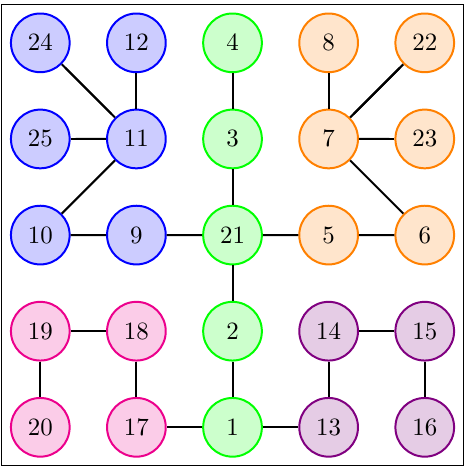
Figure 3. A proposal to rearrange the joints in a 2D format.